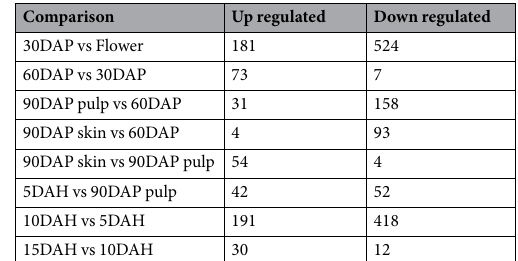
Table 3. Number of differentially expressed transcripts.